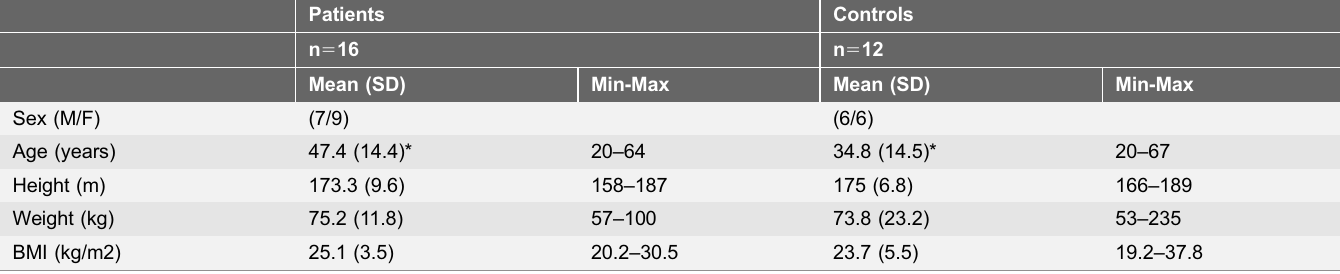
Table 3. Characteristics of patients and controls.